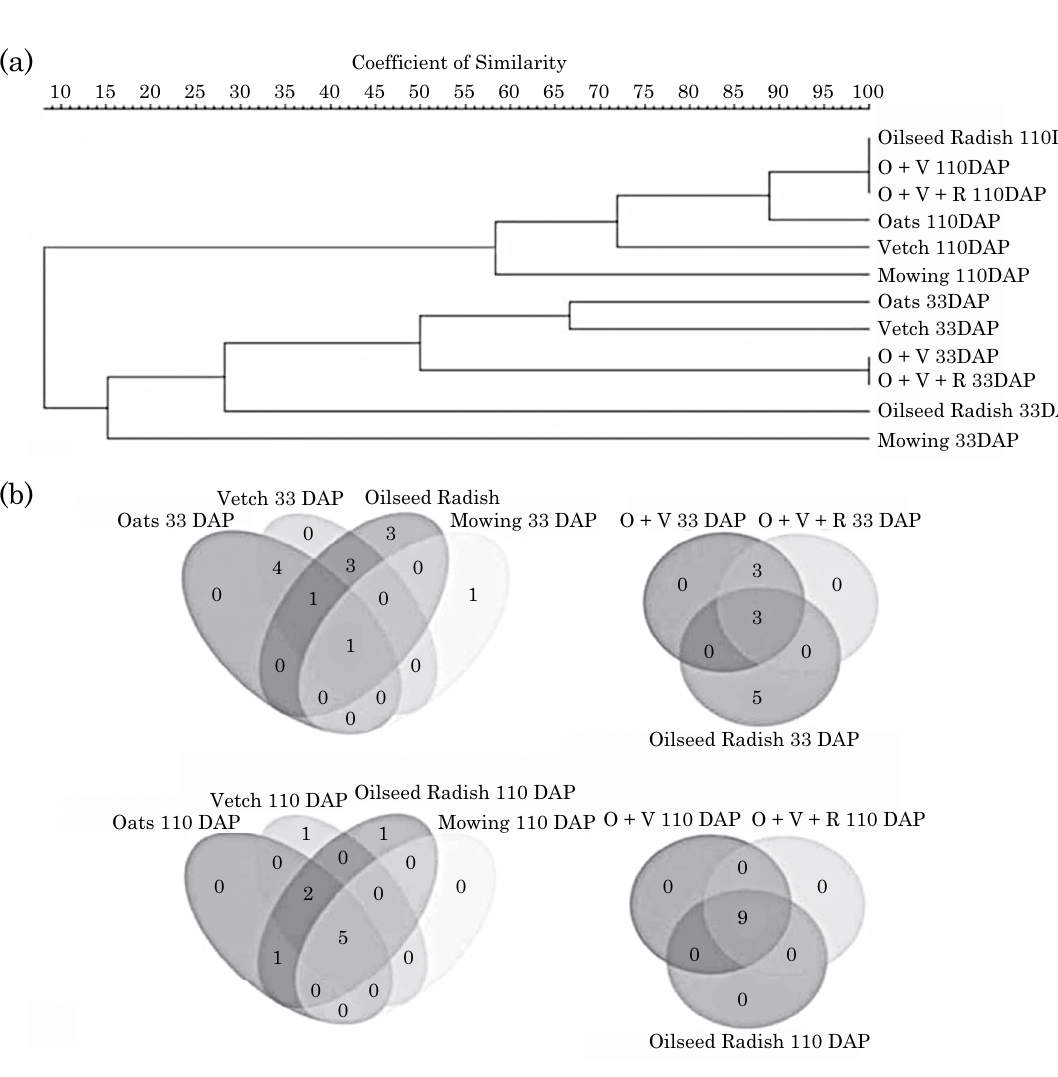
figure 2. evaluation of the structure of aMfs communities in samples of cassava roots grown in succession to different cover crops (cc). (a) dendogram generated from pcr-dgge of 12 cassava root samples, collected at 33 and 110 days after planting (dap) the stem cuttings. hierarchical clustering obtained from the Jaccard coefficient and the UPGMA clustering method. The nomenclature for the samples refers to cover crop treatments, and the numbers correspond to the collection periods. (b) venn diagram obtained through data on the presence and absence of the structure of aMfs communities of cassava root samples after dendrogram analysis, considering the period after planting (33 and 110 dap), and the cover crops of the structure of aMfs